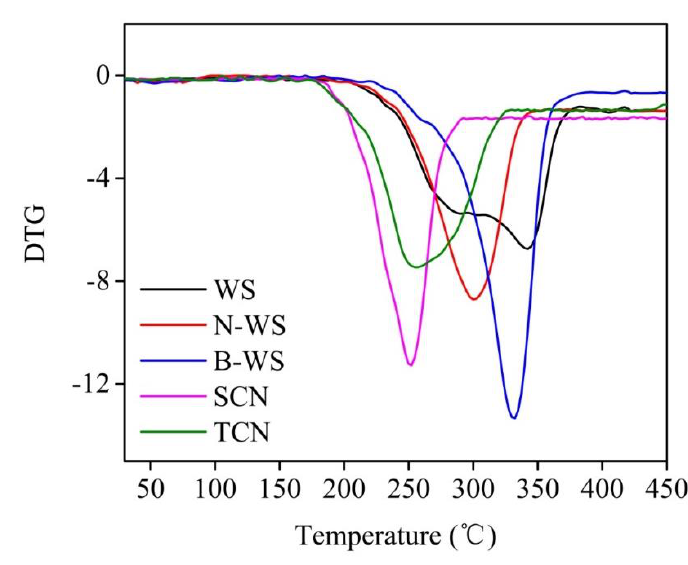
Figure 7. DTG curves of WS, N-WS, B-WS, TNC, and SNC.